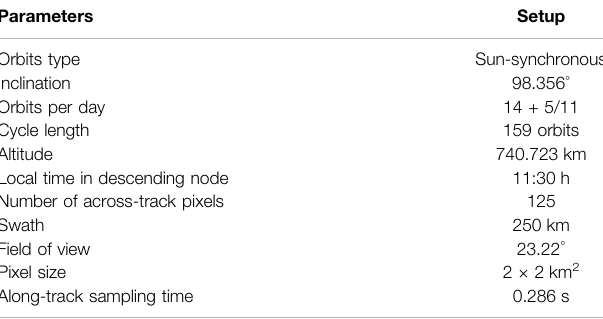
TABLE 1 | Orbits of CO2M satellite and observation geometries for its instruments.